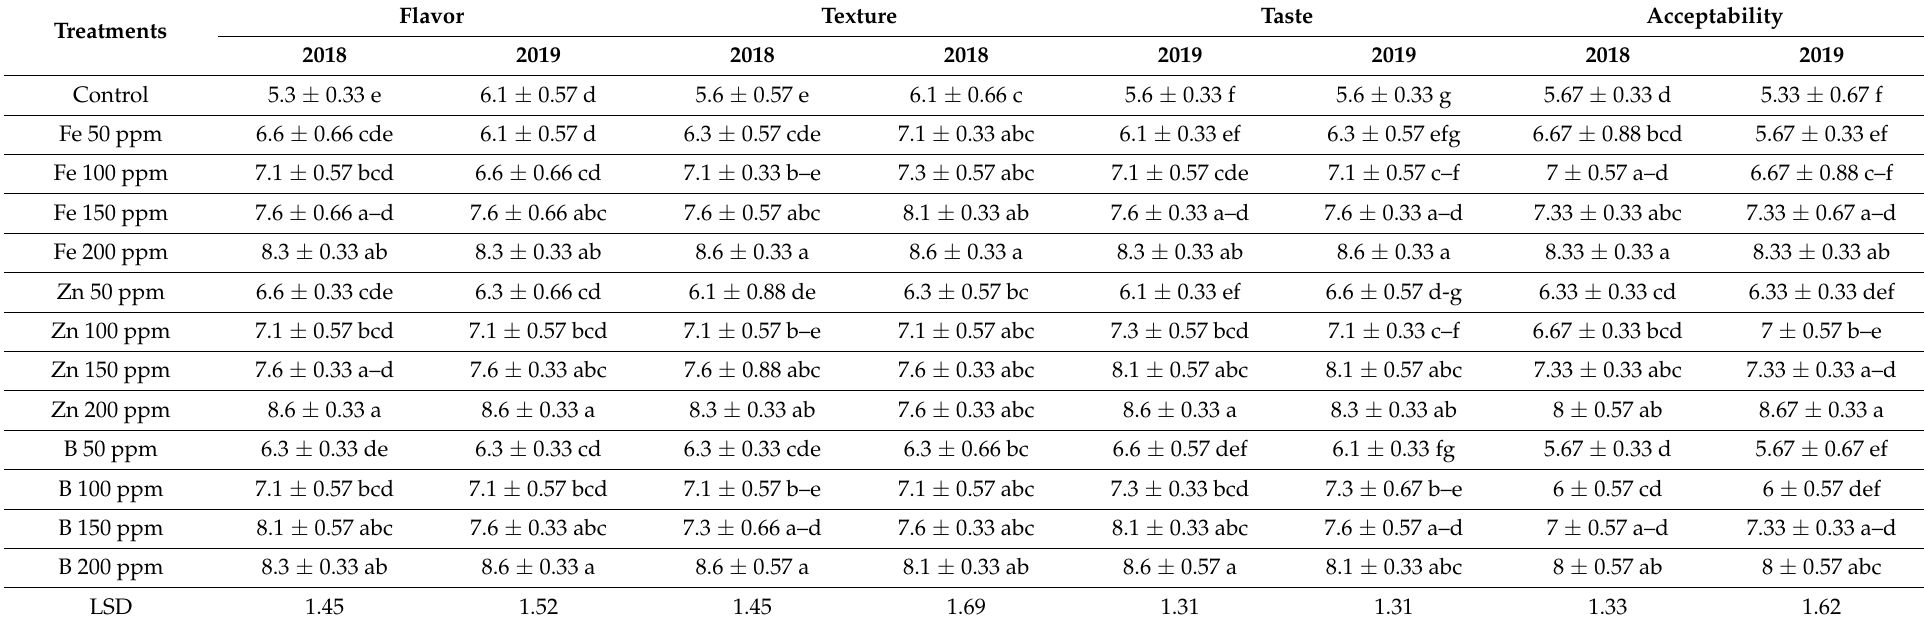
Table 6. Effect of foliar application of micronutrients on different organoleptic qualities of grapes cv. ‘Flame Seedless’ during the year 2018 and 2019. Flavor Texture Taste Treatments